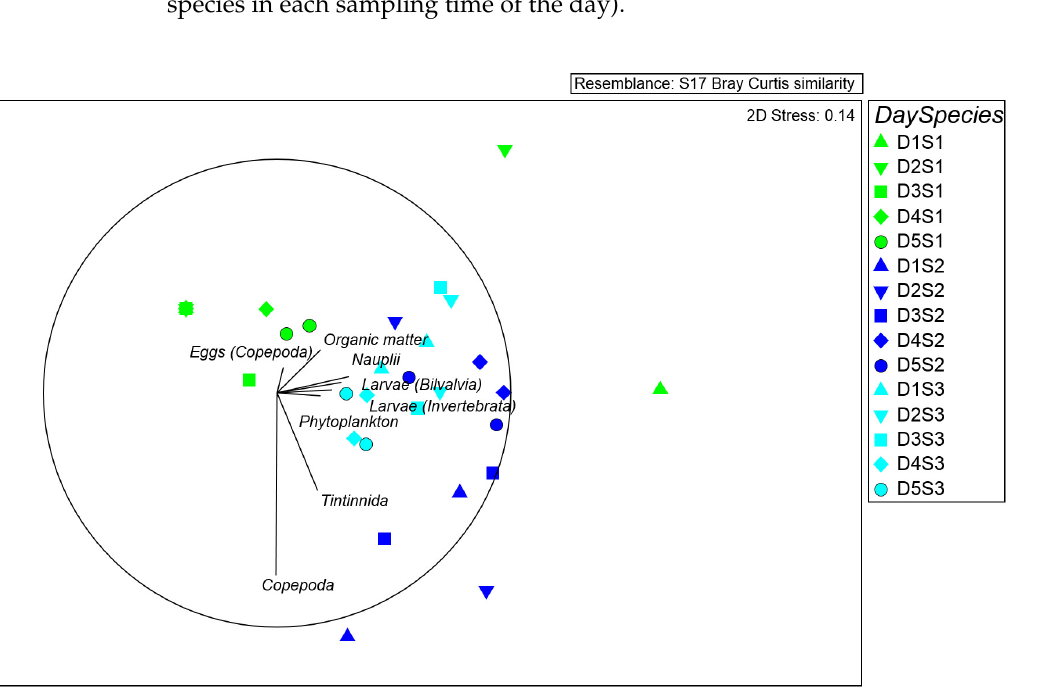
(MDS) (Figure 5), considering sampling time centroids (the mean cover values of each species in each sampling time of the day).